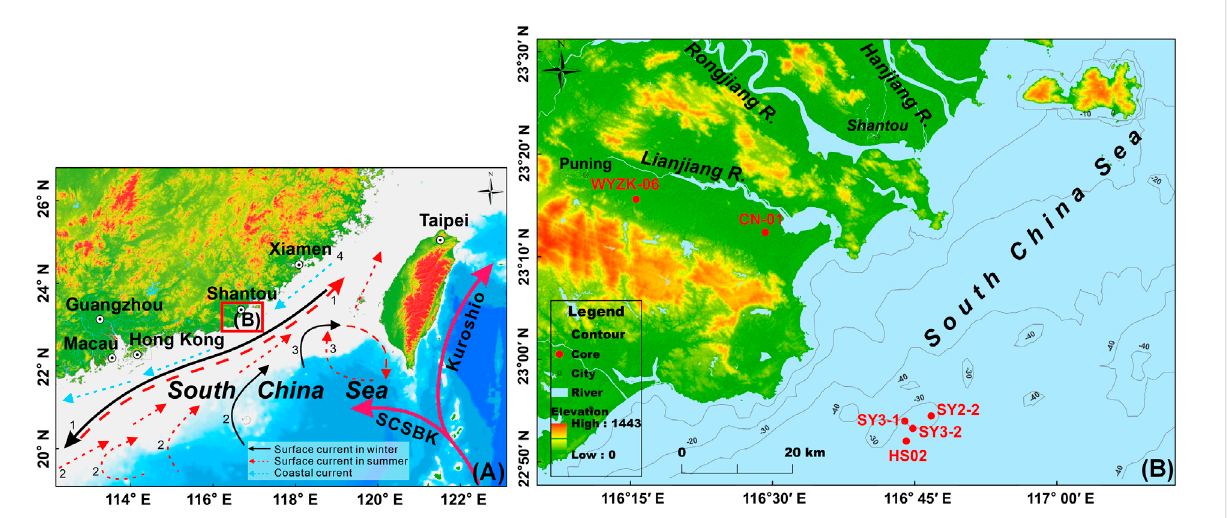
FIGURE 1 Location of the Chaoshan Plain, its neritic area, and core sites. (A) General map of the northern SCS and its signi fi cant surface circulations. The Chaoshan Plain and its adjacent neritic area are outlined by a solid red line rectangle. The surface circulations in the northern SCS were adapted from Zhang et al. (2022). The SCSBK abbreviation denotes the SCS Branch of Kuroshio, and the black numbers represent major modern surface currents, as follows: 1: Guangdong Coastal Current, 2: SCS Warm Current, 3: Loop Current, and 4: Coastal Current. (B) The major area of the Chaoshan Plain, include the Lianjiang River, Hanjiang River, and Rongjiang River plains. Four cores (SY3-1, SY3-2, SY2-2, and HS02) were obtained from the neritic area of the Lianjiang River plain. Core WYZK-06 was from Song et al. (2012), and core CN-01 was from Tang et al. (2018). Base maps from http://www.gscloud. cn/and